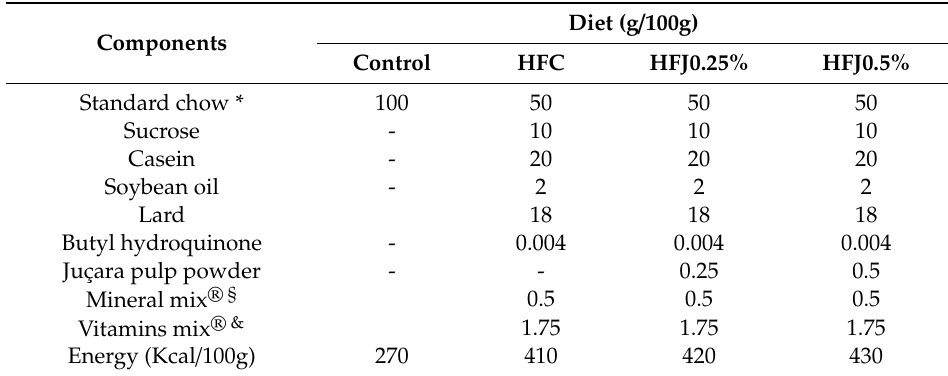
Table 4. Composition of the experimental diets used: high-fat diet control, high-fat diet juçara 0.25%, and high-fat juçara